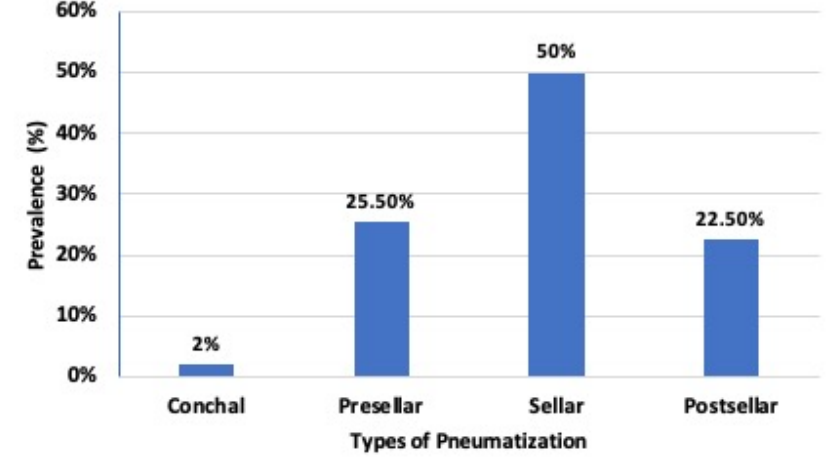
Figure 2. Prevalence of type of sphenoid sinus pneumatization.